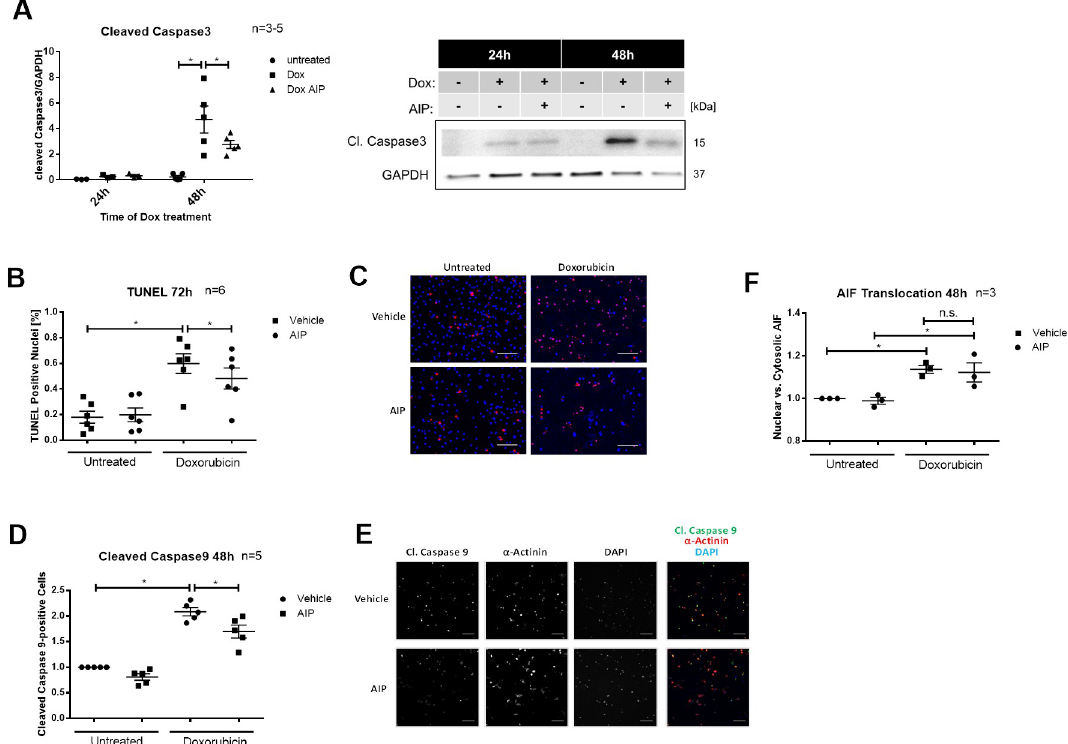
Fig 4. CaMKII activation contributes to Doxorubicin (Dox) cardiotoxicity. Neonatal rat cardiomoycytes were treated with 5 μ M AIP or vehicle starting 14h after the addition of 1 μ M Dox or medium (untreated). ( A ) Levels of cleaved caspase3 after 48h Dox treatment (n = 3–5). ( B ) Percentage of TUNEL positive cells in cells treated for 72h with Dox or medium in combination with AIP or vehicle. The ratio of DAPI positive and TUNEL positive nuclei was built. (n = 6). � P < 0.05 for matched 2-way ANOVA with Bonferroni post hoc testing. ( C ) Representative images of TUNEL positive (red) and negative cells. DAPI (blue) was used to stain nuclei. Scale bar represents 100 μ m. ( D ) Number of cells positive for cleaved caspase9 after 48h treatment with Dox or ctrl in combination with AIP or vehicle (n = 5) ( E ) Representative images for caspase9 downregulation by AIP treatment. Scale bar represents 100 μ m. ( F ) Apoptosis inducing factor (AIF) translocation: Relative signal intensity of anti-AIF antibody in the nucleus vs. cytosol after 48h Dox treatment (with and without AIP inhibition). All images except (B): p < 0.05, �� p < 0.01 and ��� p < 0.001 all for 1-way ANOVA with Bonferroni post hoc testing.